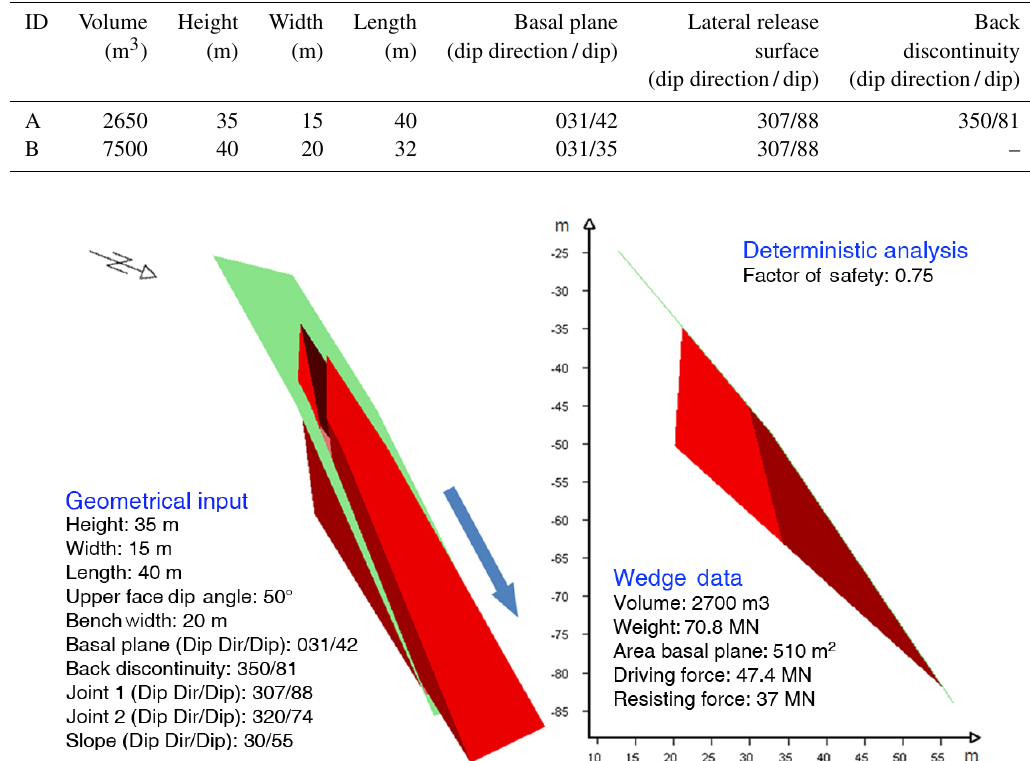
Figure 10. Result of Rocscience ™ Swedge 3-D preliminary slope stability